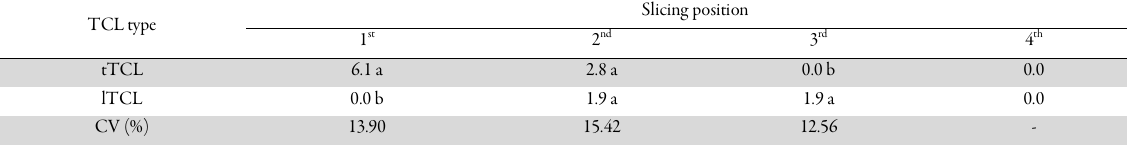
Table 2. Interaction effect of TCL types and slicing positions on number of leaves per explant TCL type